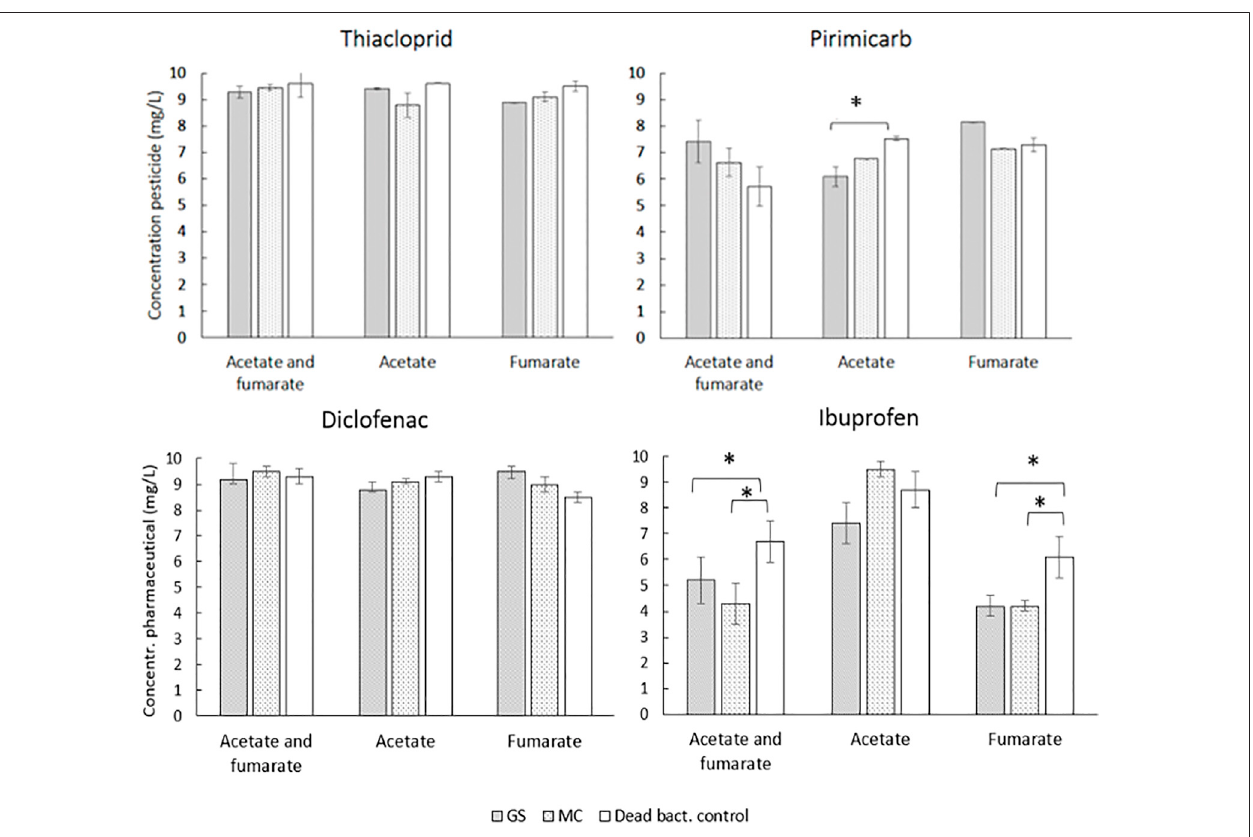
FIGURE 5 | Concentrations of pesticides and pharmaceuticals in freshwater medium after 14 days. Values represent means of triplicates ±SD. Gs = G. sulfurreducens ; MC = Mixed culture. *indicates a signi fi cant difference at p ≤ 0.05, n = 3 (one-way ANOVA, factor Bacteria).